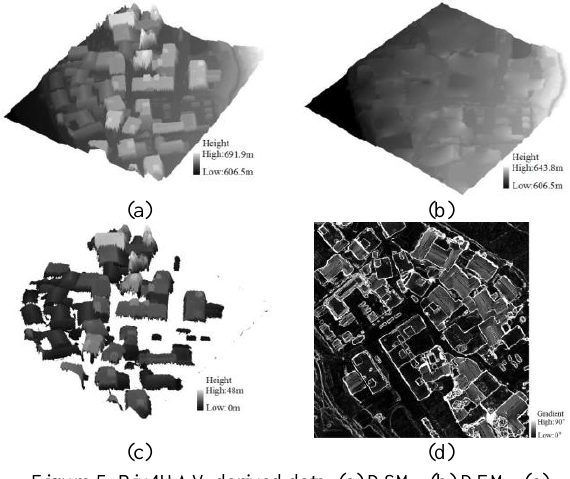
Figure 5. Pix4UAV derived data: (a) DSM; (b) DEM; (c) nDSM; (d) gradient image.